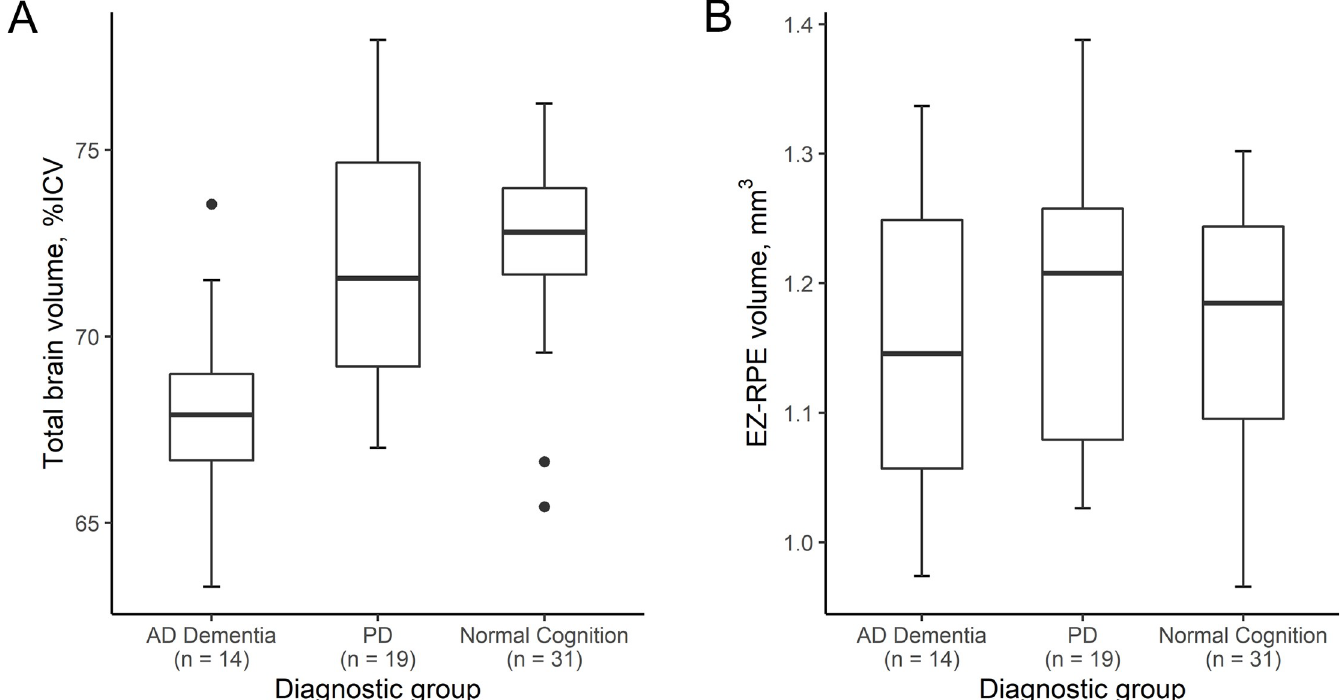
Fig 2. Box plots demonstrating total brain volume and ellipsoid zone (EZ) to retinal pigment epithelium (RPE) volume. A. Total brain volume normalized as a percentage of intracranial volume (%ICV) of each diagnostic group. Middle horizontal line inside the box indicates median. Bottom and top of the box are 25th and 75th percentiles, respectively. The ends of the whisker show the minimum and maximum for each group. Dots represent outliers defined as values over 1.5 box lengths from either end of the box. B. EZ-RPE (i.e., photoreceptor outer segment) volume of each diagnostic group.